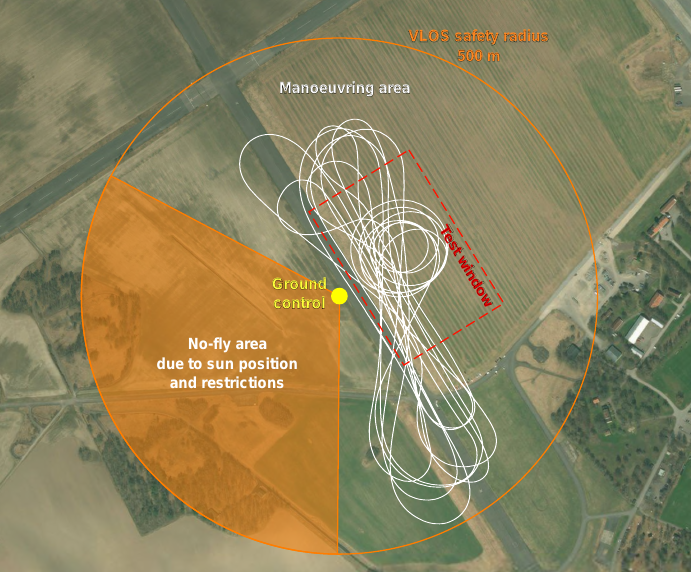
Figure 9. Example of SFT at level 2 using the concept of test-window and flexible pattern. This specific flight of the GFF demonstrator corresponds to the manoeuvres and performance data shown in Figure